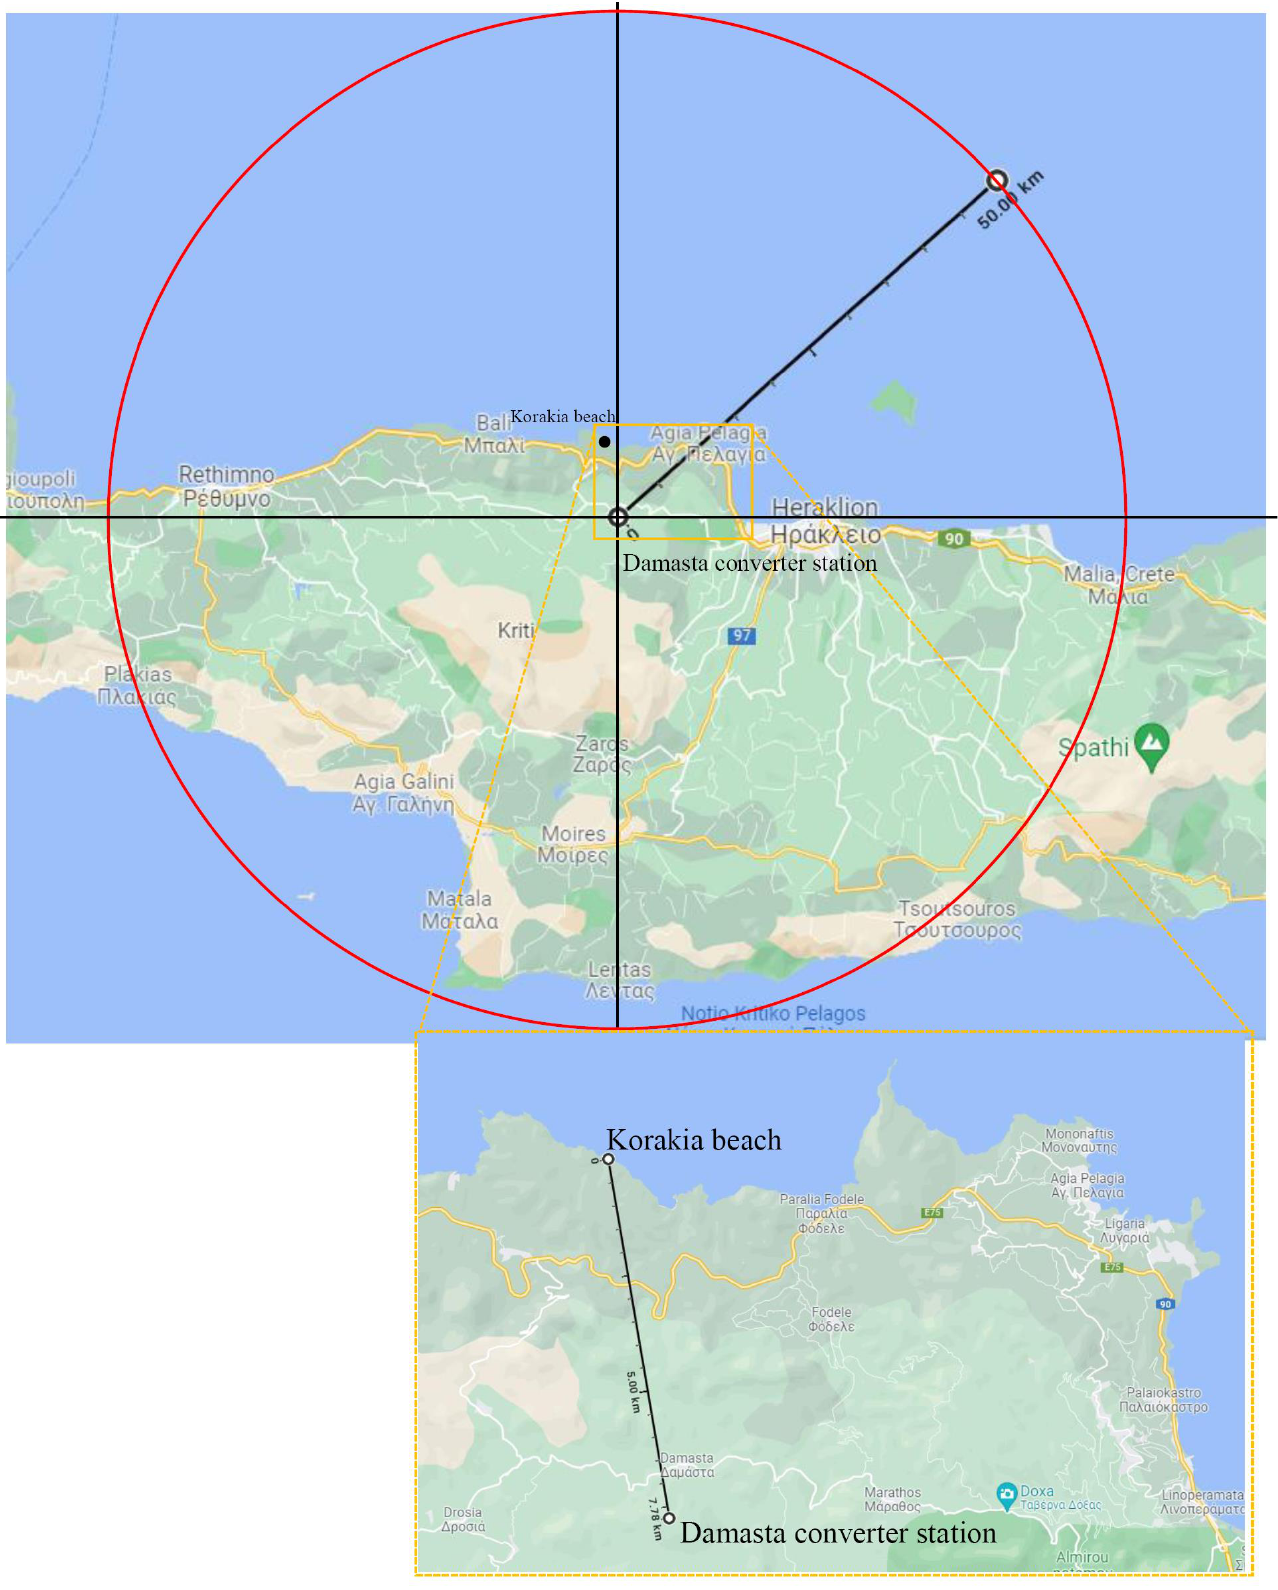
Figure 3. Location of the electrode station for an HVDC transmission system in the region of Crete. EPRI proposes the use of numerical algorithms using resistivity data from geophysical methods [45], which are more widely used in grounding electrodes [61] but also in